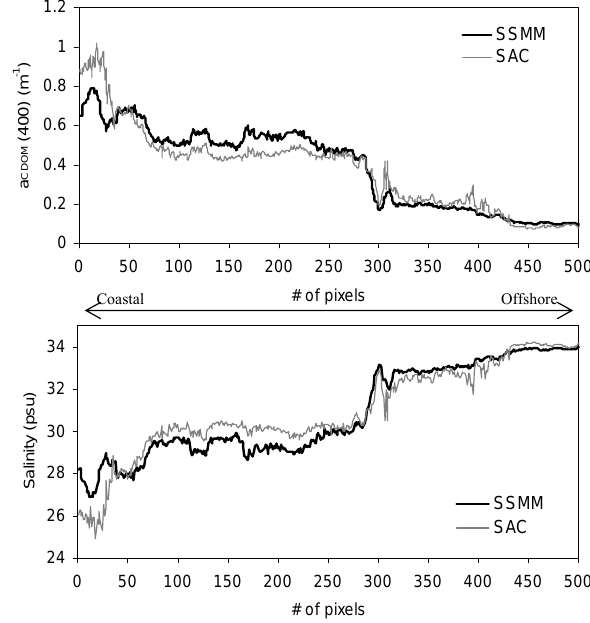
Fig. 10. Horizontal profiles from the SeaWiFS image of 5 April 2005 illustrating the spatial variability of a CDOM (400) (m − 1 ) and salinity (psu) fields along a transect running across the LSW plume from bright coastal waters in the YR estuary to dark ocean waters in the vicinity of the Kuroshio (black line on the salinity image in Fig. 9). SAC – standard atmospheric correction scheme, and SSMM – spectral shape matching method scheme.